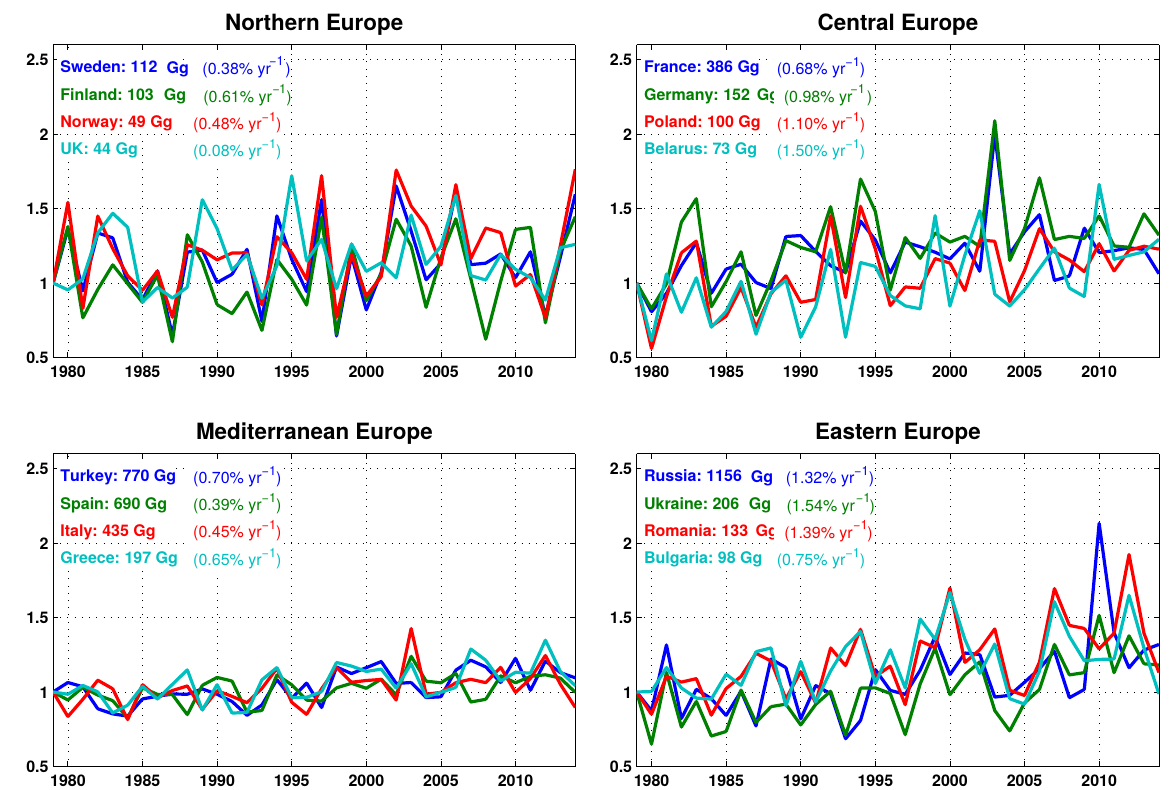
Figure 4. Annual isoprene emissions normalized to the emission in 1979 for 16 European countries. In the upper left corner of every panel the total isoprene emissions for every country in 1979 are given as well as the emission trend over 1979–2014. The emissions are obtained from the H3 simulation (Table